Question: Which visualization type does this figure use?
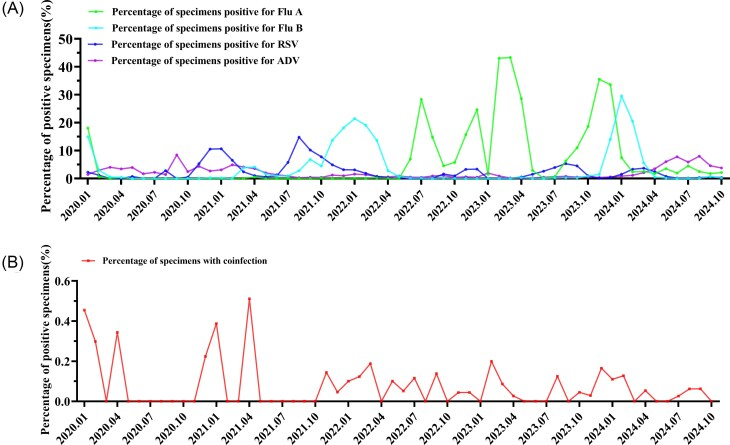
Answer: line